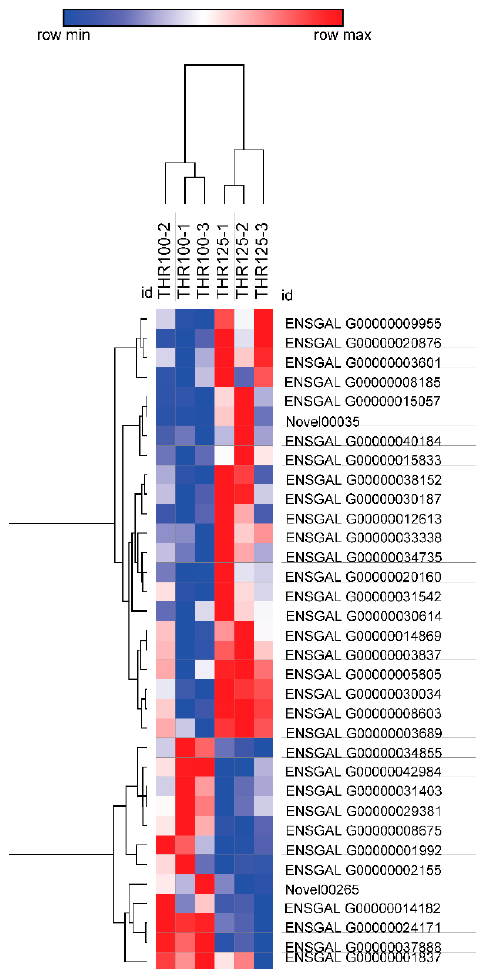
Figure 5. Expression profiles of differential genes between THR100 and THR125 . The heat map showed the differential gene expression profiles in THR100 and THR125 groups. Each row represents the level of expression of each differentially expressed gene; each column represents a biological repetition. The expression level of each gene is expressed by fragments per kilobase of exon per million reads mapped (FPKM) value. The FPKM value for each differential gene was used for plotting. Red indicates that the gene is highly expressed, and blue indicates a low expression level.